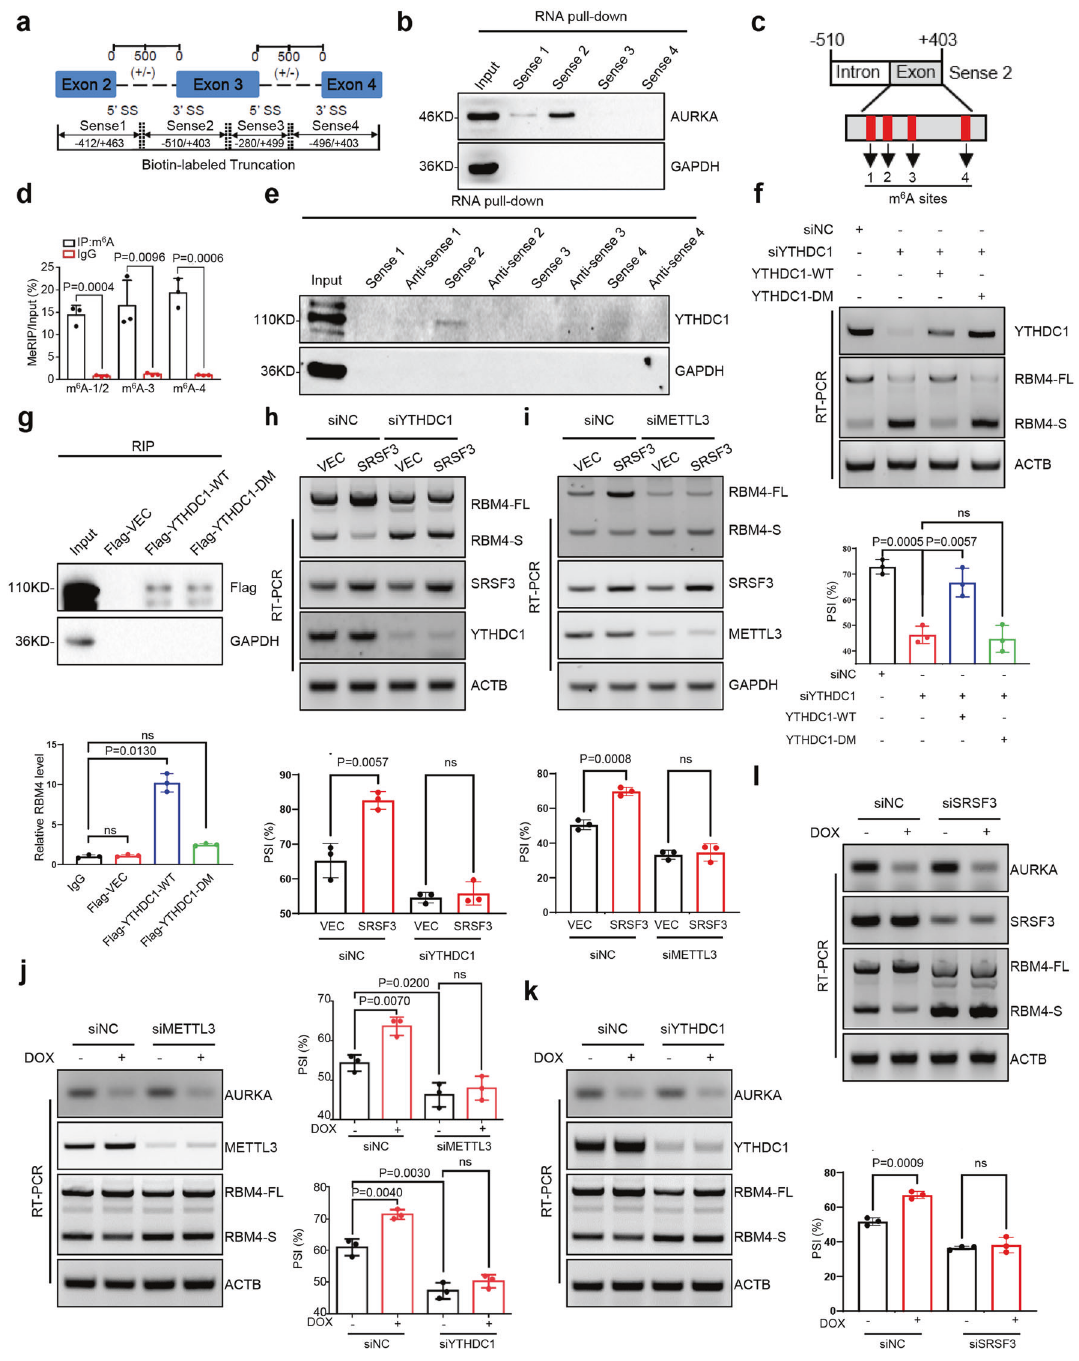
Fig. 3 Nuclear AURKA inhibits m 6 A-YTHDC1-SRSF3-mediated RBM4 exon inclusion. a RBM4 gene was truncated into four parts, each of which was applied to an in vitro transcription assay with Biotin-labeled as indicated. Sense 1: − 412/ + 463, Sense 2: − 510/ + 403, Sense 3: − 280/ + 499, Sense 4: − 496/ + 403. b The streptavidin beads-immobilized biotin-labeled RNA truncations were incubated with A549 cell lysates and an RNA pull-down assay was performed. c Four potential m 6 A sites located in the Sense 2 ( − 510/ + 403) region of RBM4 pre-mRNA. d RNA methylation modi fi cation was detected by the methylated RNA-immunoprecipitation (MeRIP)-qPCR assay in A549 cells. e The PCR products of RBM4 truncated sense and anti-sense regions were applied to an in vitro transcription assay with Biotin-labeled. Binding of these RNA truncations with YTHDC1/GAPDH proteins was examined by an RNA pull-down assay in A549 cells. f RBM4 splicing change in YTHDC1-WT (wild-type) and YTHDC1-DM (m 6 A binding region mutant) reconstitution endogenous YTHDC1 depleted A549 cells was detected by RT-PCR. g Binding of RBM4 pre-mRNA with IgG or exogenous Flag-VEC/Flag-YTHDC1-WT/Flag-YTHDC1-DM protein was detected by RIP-qPCR assay in A549 cells. h The level of YTHDC1 or i METTL3 was depleted in control and SRSF3 overexpressed A549 cells. Relative mRNA abundance of SRSF3, YTHDC1/METTL3, and RBM4 splicing was examined by RT-PCR. j The level of METTL3 or k YTHDC1 or l SRSF3 was depleted in A549-Tet-On-shAURKA cells with or without DOX induction. Relative mRNA abundance of AURKA, METTL3/YTHDC1/SRSF3, and RBM4 splicing was examined by RT-PCR. Data are shown as means± SD. P - values were calculated with two-tailed unpaired Student ’ s t -test and P <0.05 is considered statistically signi fi cant